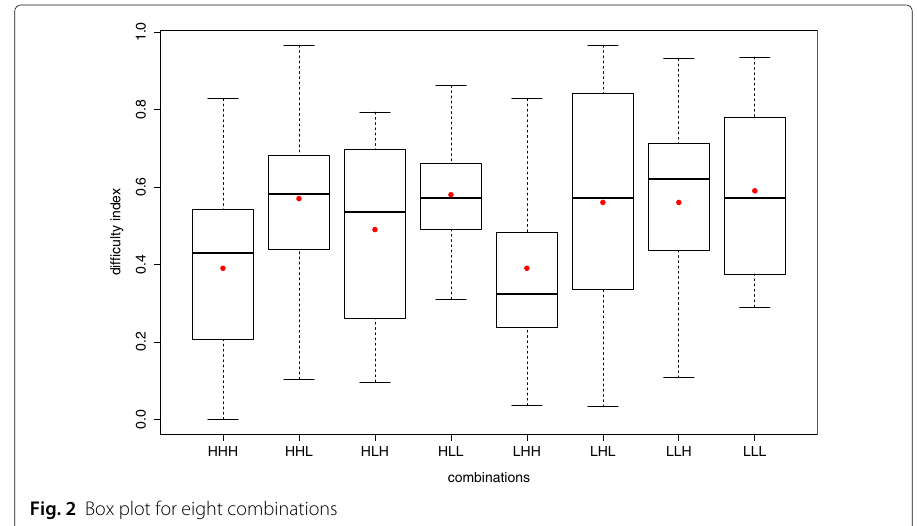
Fig. 2 Box plot for eight